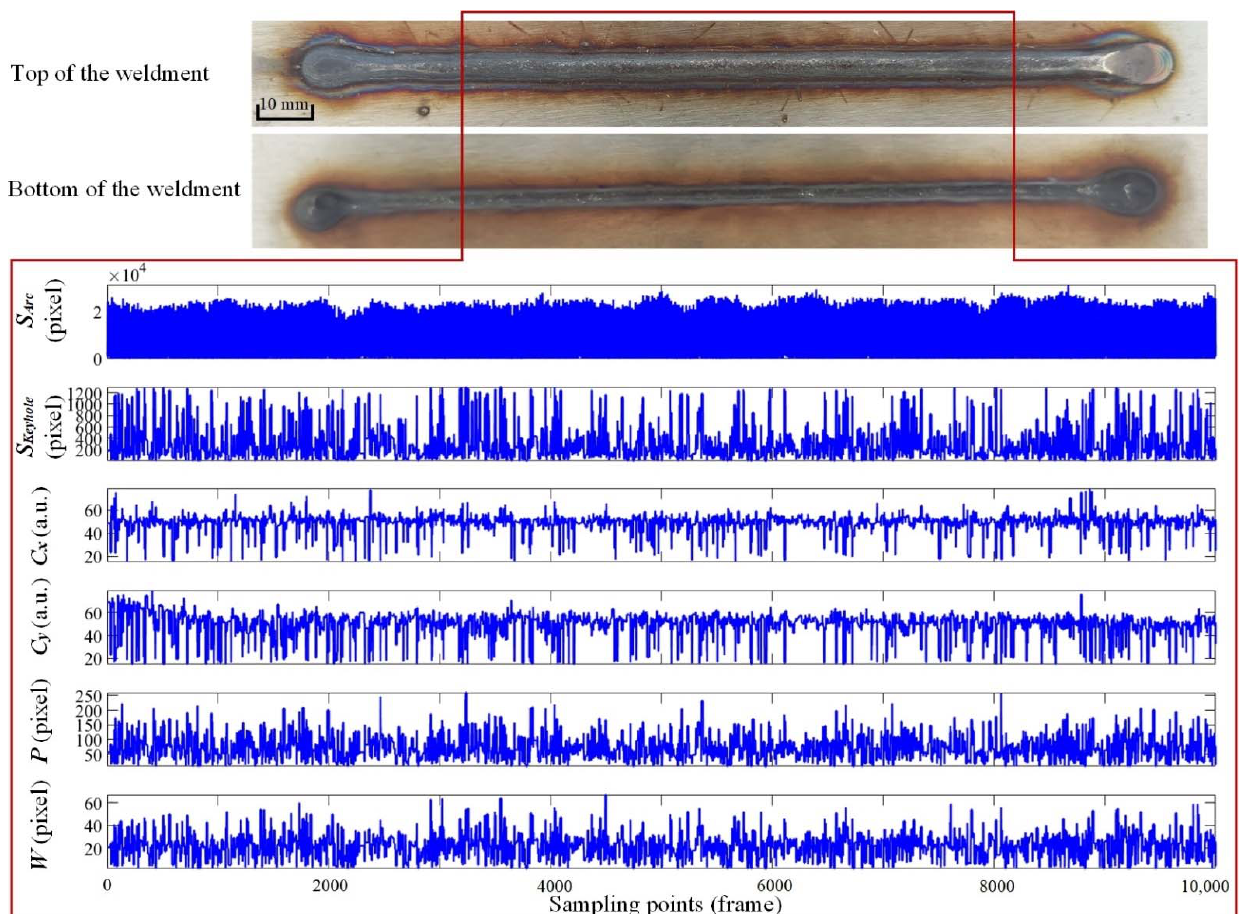
Figure 11. Visual features of normal penetration (No.3) in the laser ‐ MIG hybrid welding